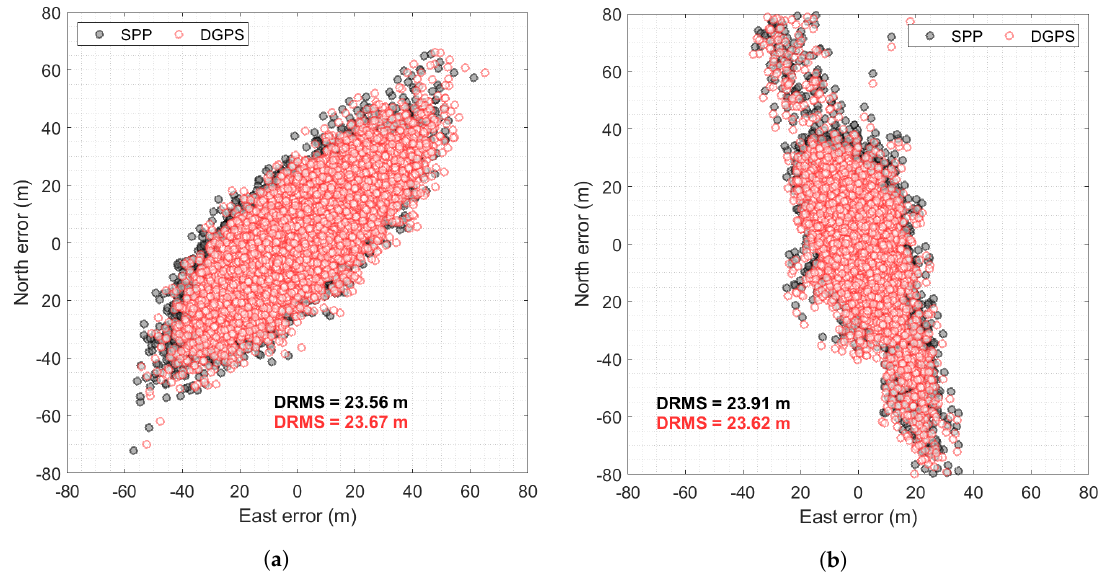
Figure 8. Scatter plot of the Single-Point position and Code Differential error. Grey markers represent errors for the Single-Point solution, red circles represent error for the DGPS approach: ( a ) Steering on; ( b ) steering